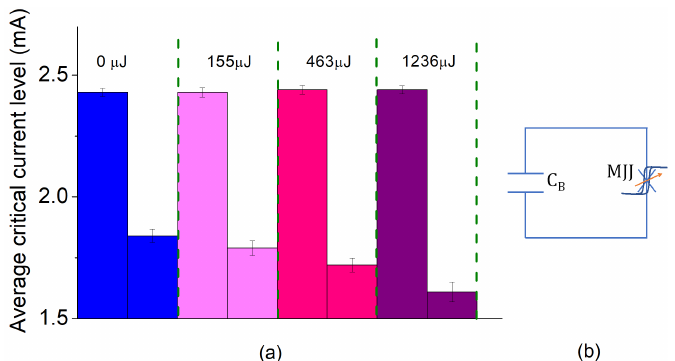
Figure 2. ( a ) Critical current levels obtained using RF trains with different nominal energies. ( b ) Sketch of the MJJ in parallel with the shunting capacitance C B typical of the transmon design. Acknowledgments: The authors thank NANOCOHYBRI project (Cost Action CA 16218). Conflicts of Interest: The authors declare no conflict of